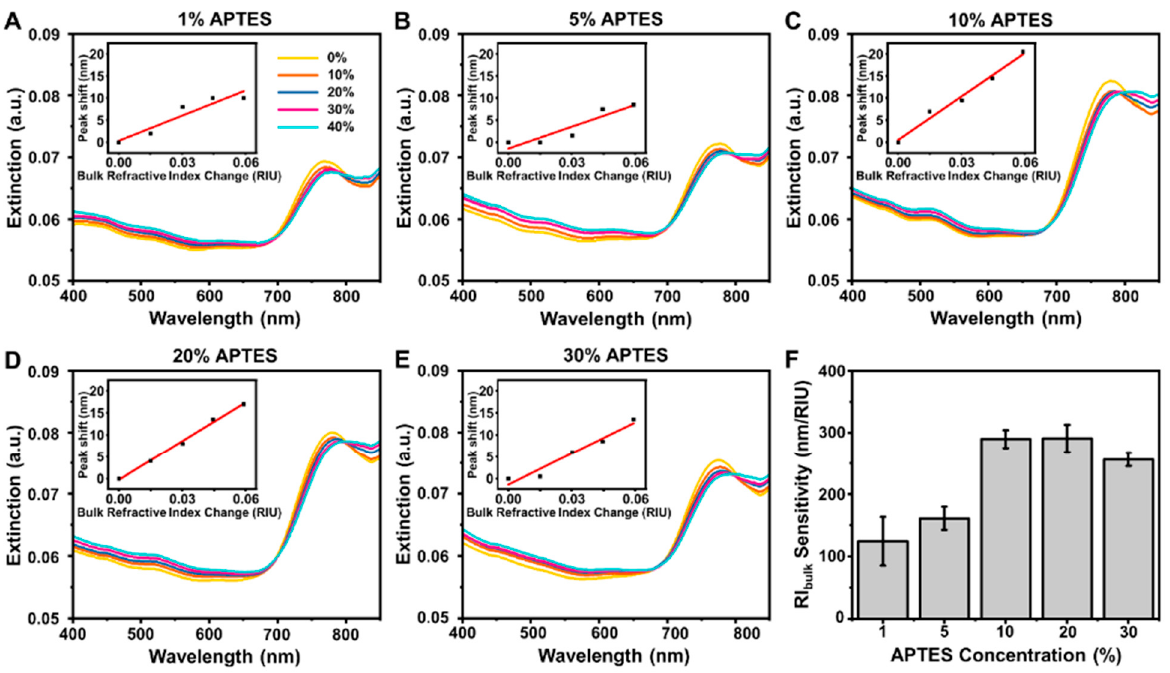
Figure 3. ( A – E ) Representative optical extinction spectra of fabricated AuNR platforms in different water-glycerol mixture environments (0–40% v / v glycerol). Insets are linear fits of the corresponding Δ λ max shifts as a function of the bulk refractive index change in the different water–glycerol mixtures. The platforms were fabricated using different APTES concentrations to functionalize the glass surface prior to AuNR deposition. ( F ) Summary of bulk refractive index values for different AuNR platforms. Data are reported as the mean ± standard deviation from three experiments.